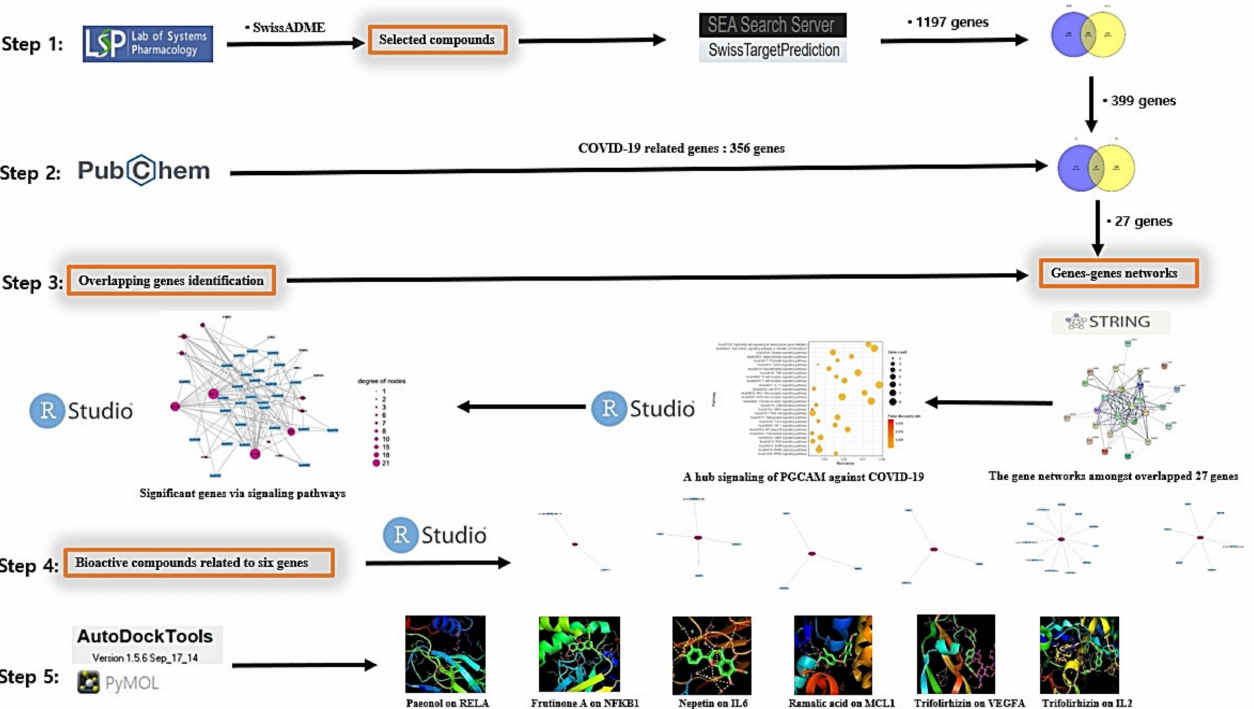
Figure 1. Workflow of network pharmacology analysis of PGCAM against